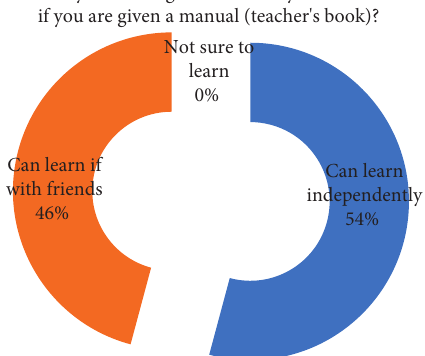
Figure 8: Teachers’ responses to their skills to use AR.